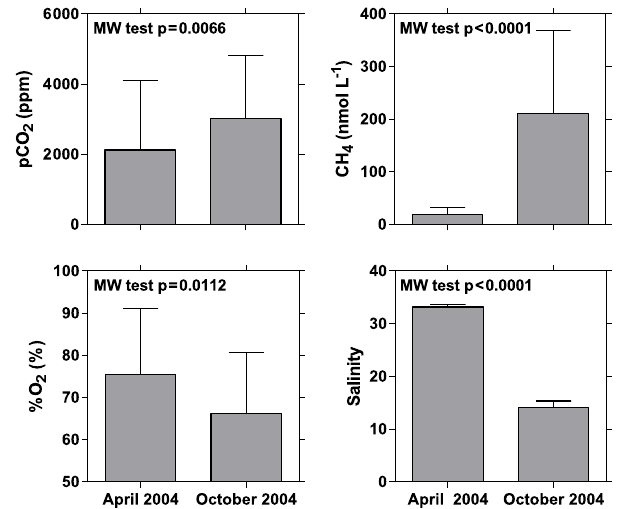
Figure 11. Average ± standard deviation of the partial pressure of CO 2 (pCO 2 , ppm), oxygen saturation level (%O 2 , %), dissolved CH 4 concentration (nmolL − 1 ) , and salinity in the mangrove creeks of the Ca Mau province in April and October 2004. MW: Mann– Whitney (at 0.05 level).